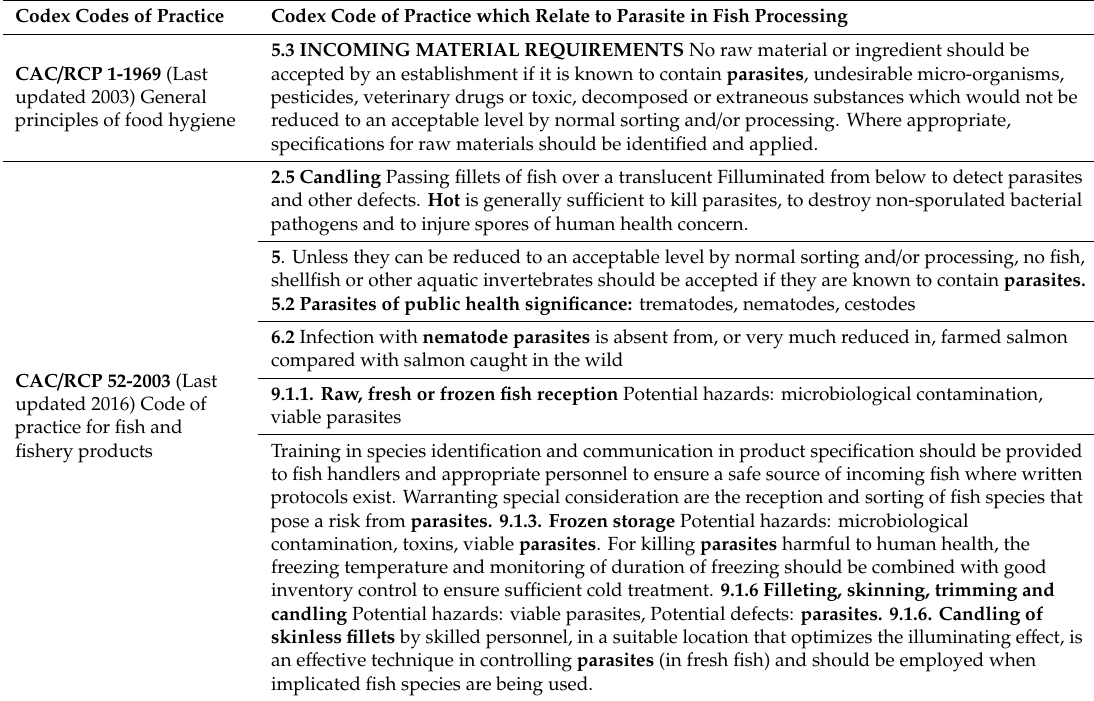
Table A1. Appendix A Represents all Codex Alimentarius food safety codes of practice / standards and guidelines relating to zoonotic parasites in seafood. In orange are those documents which contain specific advice pertaining to zoonotic parasite and those which do not are shaded in green. Table developed from information at Food and Agriculture Organisation (2018) and information is taken verbatim from each of the codes of practice / standards and guidelines which relate to control of zoonotic